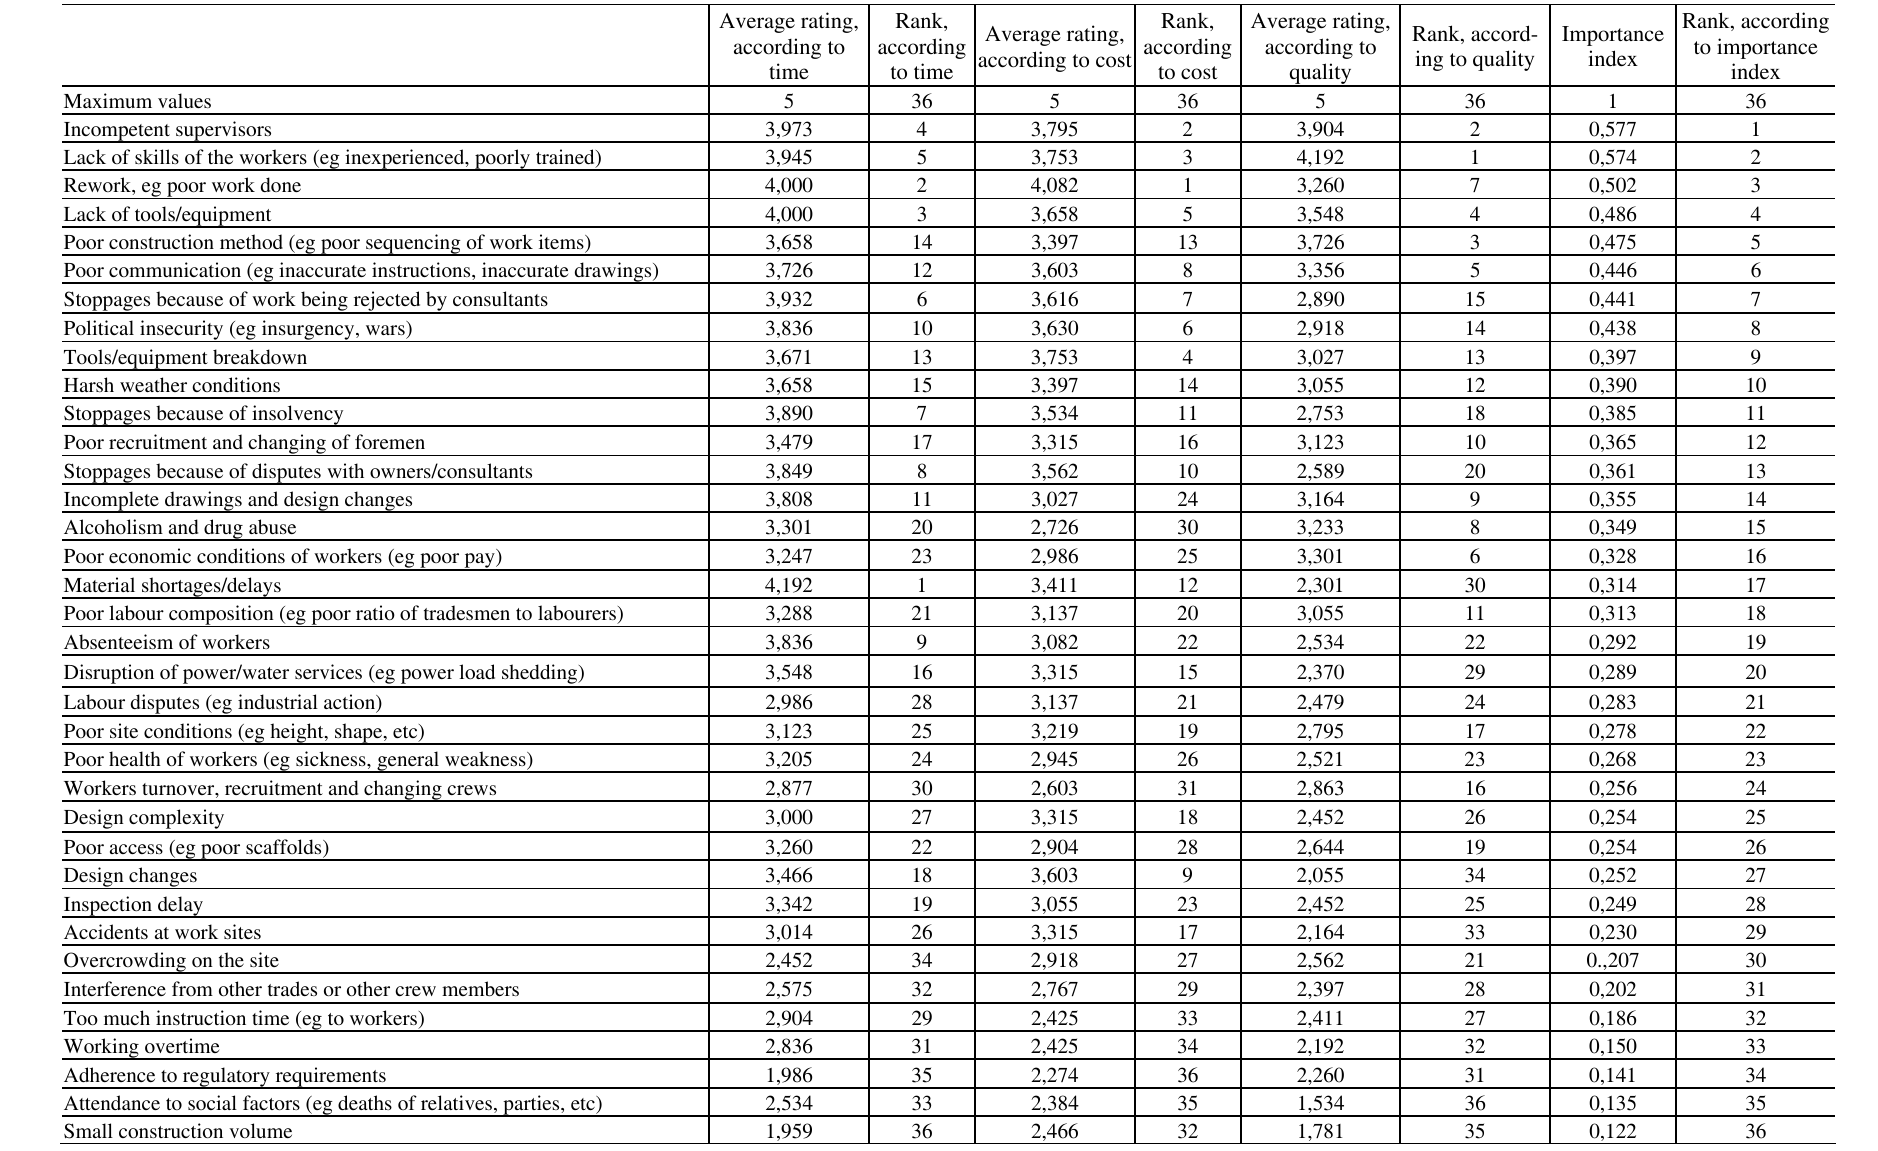
Table 2. Ranking of factors according to time, cost, quality and combined importance index